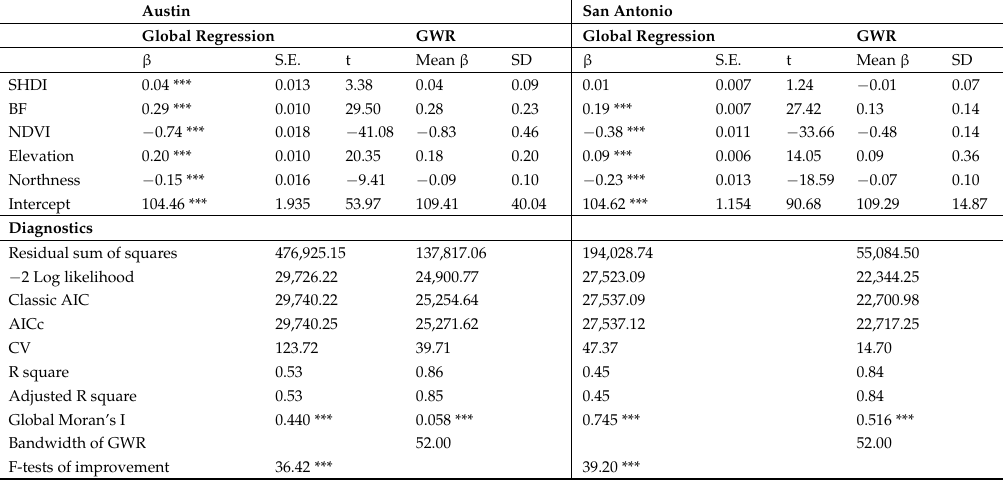
Table 4. Comparison of global regression and Geographically Weighted Regression (GWR): summary of the coefficients and diagnostics.